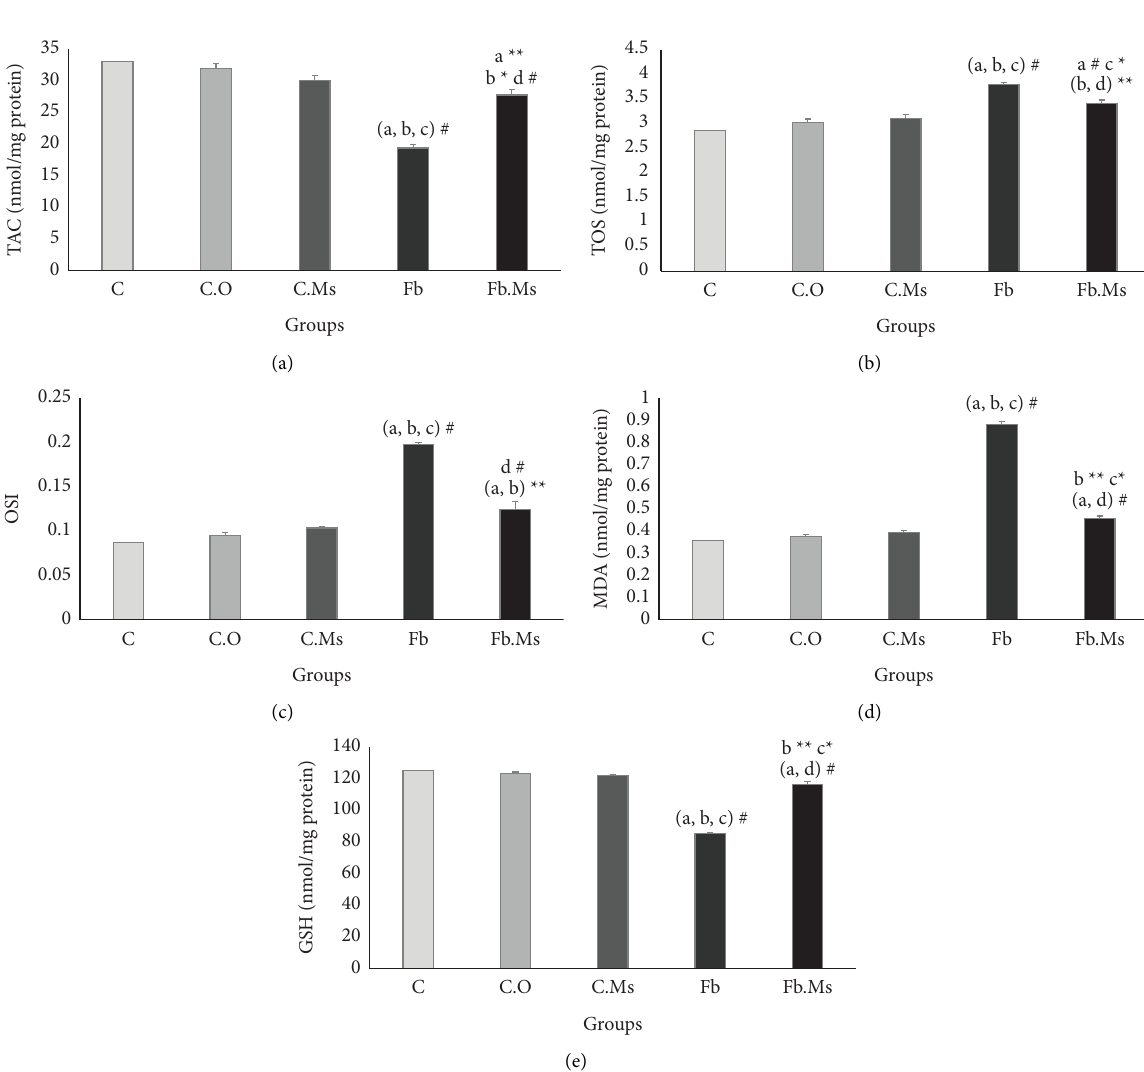
Figure 2: Te results of the oxidative stress markers in the lung tissue of the studied animals. (a) Total antioxidant capacity (TAC), (b) total oxidant status (TOS), (c) oxidative stress index (OSI), (d) malondialdehyde (MDA), (e) glutathione (GSH), C: control group; C.O: olive oil control group. C.Ms: hMSC-CM control group, Fb: fbrosis group, Fb.Ms: group Fb with hMSC-CM treatment. ( ∗ p < 0 . 05, ∗∗ p < 0 . 01, # p < 0 . 001). a Signifcantly diferent from C. b Signifcantly diferent from C.O. c Signifcantly diferent from C.Ms. d Signifcantly diferent from that of